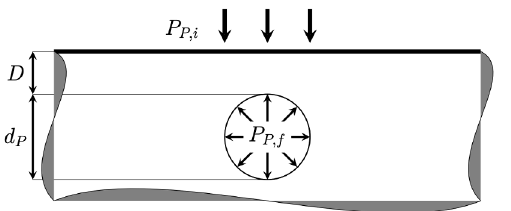
Figure 4. Schematic of the edge effect, where the final pore pressure, P P , f , is amplified due to the close proximity to the rock